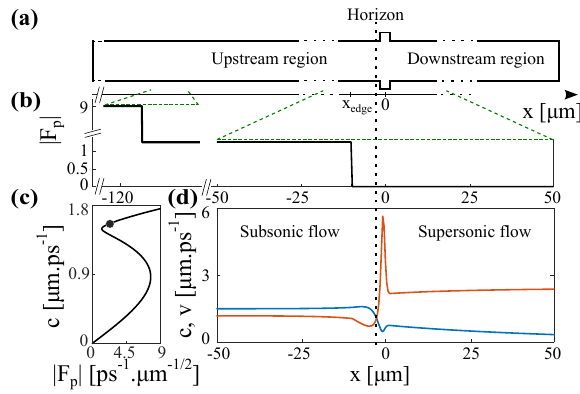
Figure 1. Acoustic horizon in a trans-sonic polariton fluid . A step-like laser field pumps polaritons, creating a trans-sonic fluid flow across an attractive obstacle. (a) Sketch of the polariton wire with a defect at x d = 0. (b) Optical bistability of the spatially homogeneous polariton fluid. (c) Spatial profile of the pump near the defect. The pump intensity | F p | [ps − 1 .µ m − 1 / 2 ] drops abruptly to 0 at x ed g e = − 10 µ m. (d) Spatial properties of the fluid near the defect: orange, fluid velocity v ; blue, speed of excitations c . Figure adapted from